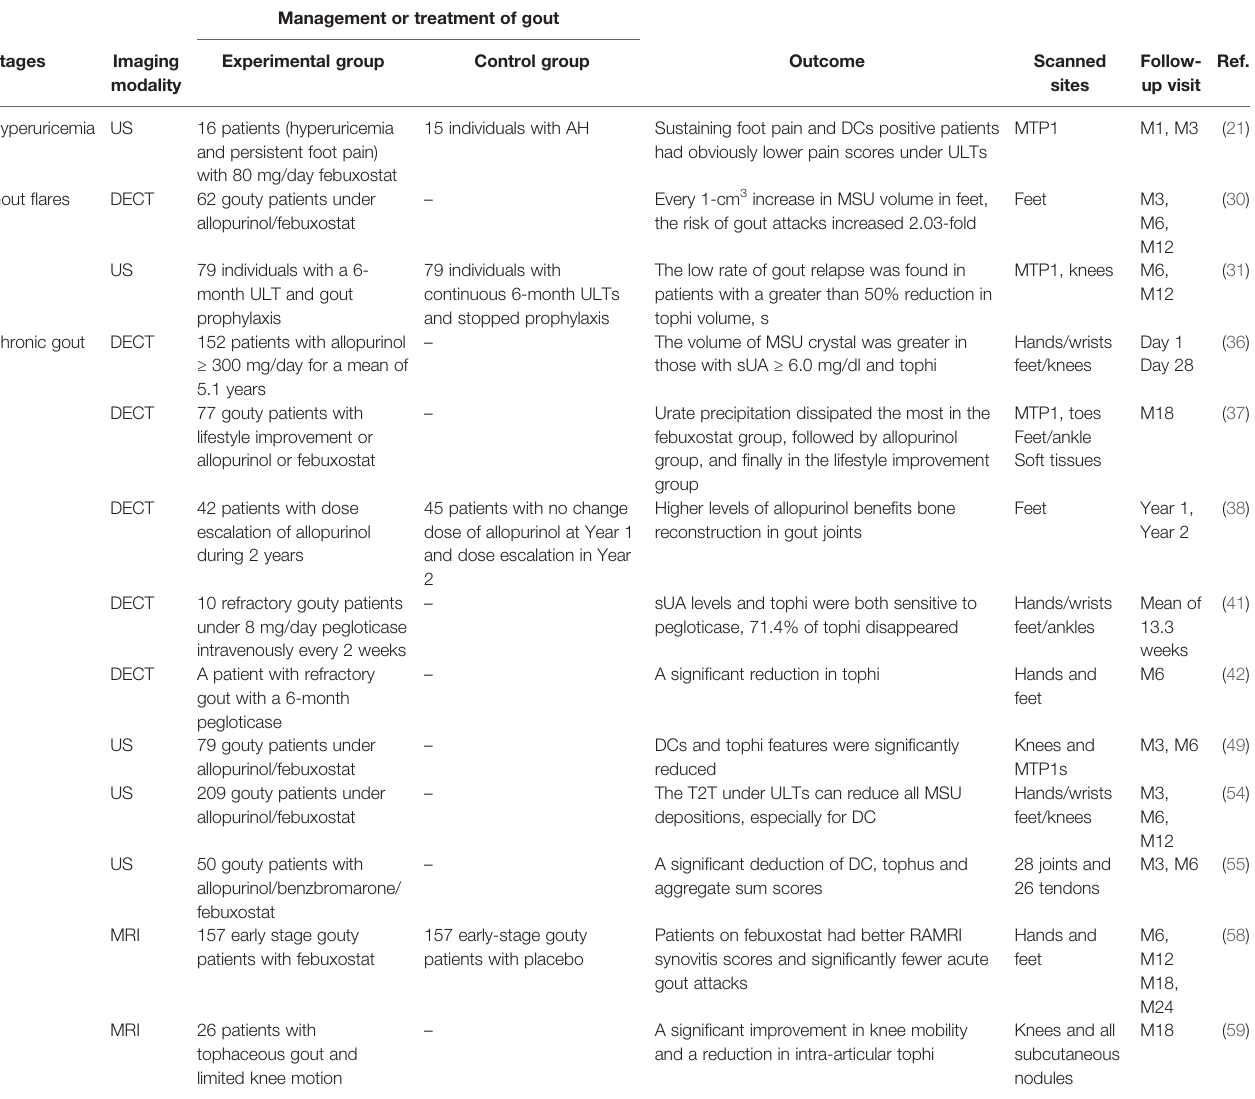
TABLE 1 | The role of imaging in monitoring treatment in the different stages of